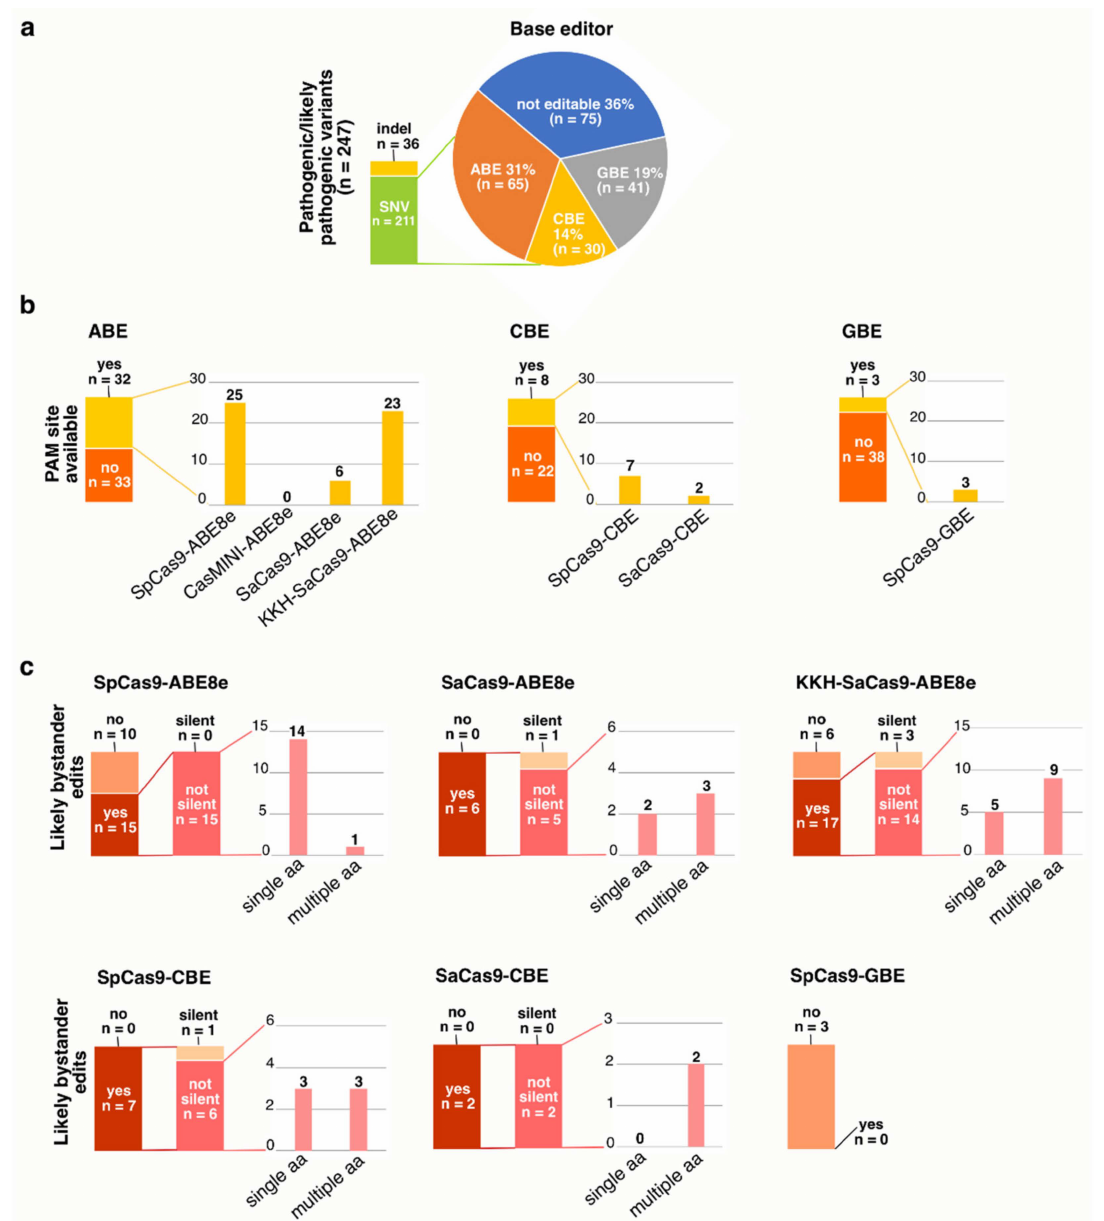
Figure 5. Base editing options for disease-associated RHO variants. ( a ) LOVD, ClinVar and gnomAD datasets included altogether 247 unique RHO variants that were interpreted as pathogenic or likely pathogenic in at least one of the datasets. Judging by the variant type, 31% of the SNVs could be corrected with ABE, 19% with GBE and 14% with CBE. ( b ) Available PAM sites were found for 49% of the ABE-editable variants, 27% of the CBE- and 7.3% of the GBE-editable variants. Available PAM sites were more commonly found for SpCas9-ABE8e and KKH-SaCas9-ABE8e constructs, which enabled guide RNA design for 25 and 23 disease-associated variants, respectively. ( c ) Bystander edits were likely to be introduced in the majority of guide RNAs for all constructs except the SpCas9-GBE. Amongst predicted bystander edits, amino acid-changing bystanders were more common than silent variants for all constructs. The majority of SpCas9-ABE8e-guides were likely to introduce bystander edits that result in one amino acid being changed, whereas bystander edits in SaCas9-ABE8e-, KKH-SaCas9-ABE8e- and SaCas9-CBE-guides were predicted to alter multiple amino